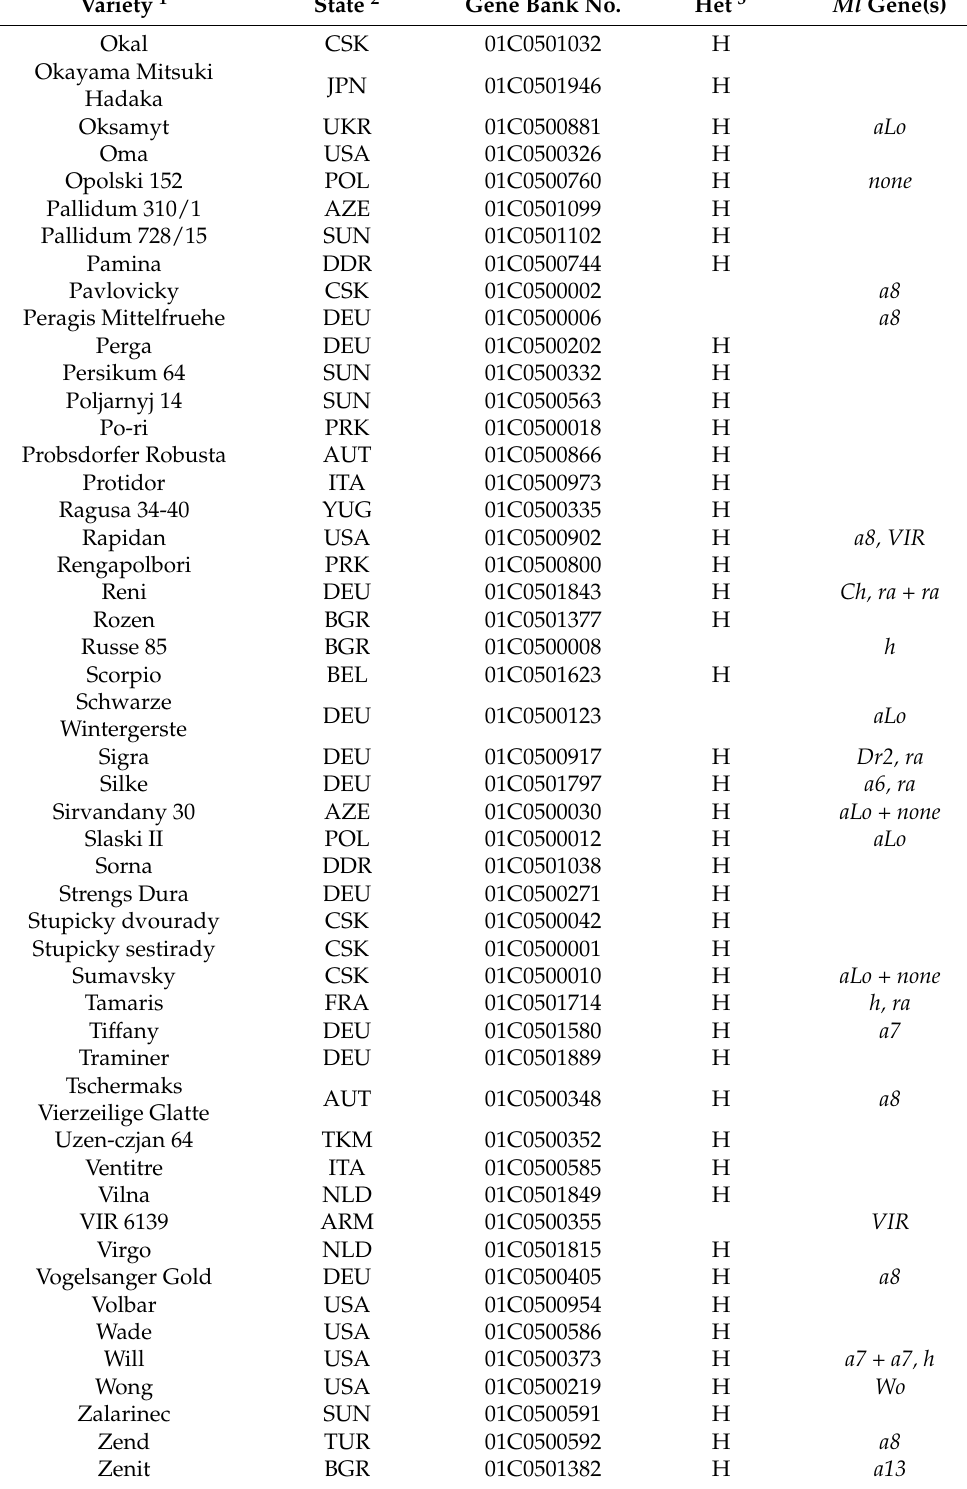
Table 2. Cont. Variety 1 State